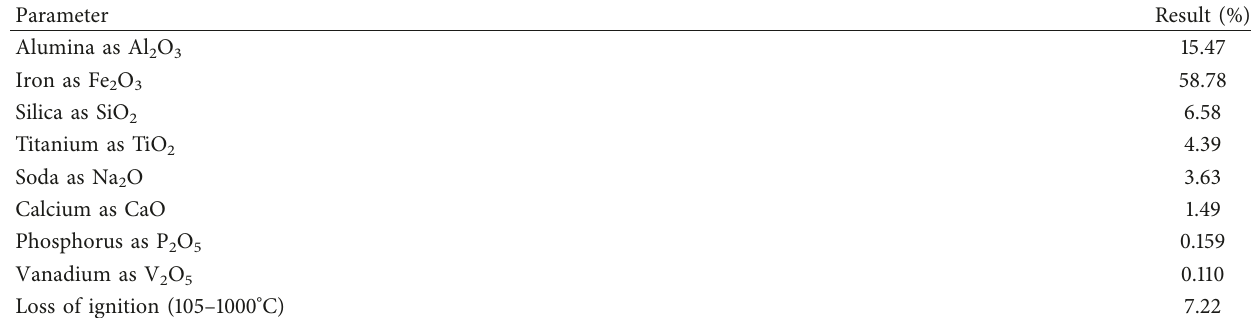
Table 1: Chemical properties of red mud.